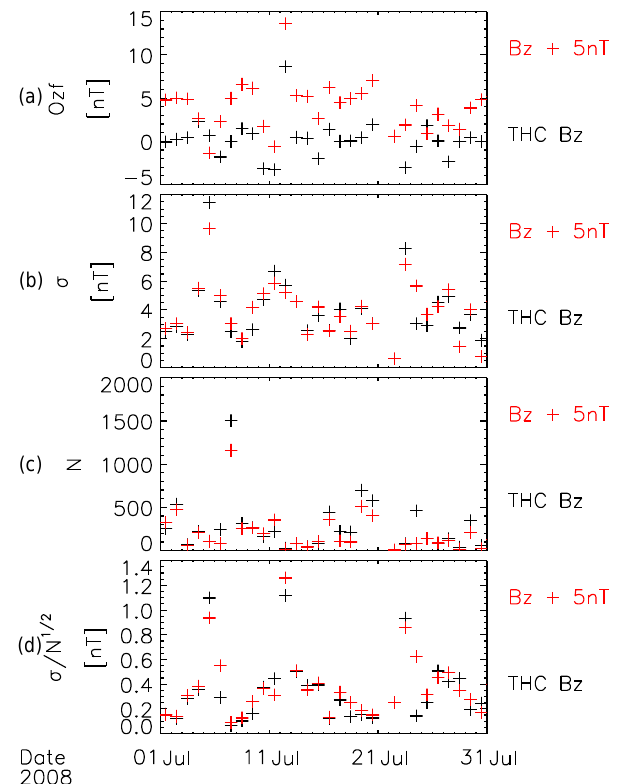
Figure 5. Daily spin axis offsets O z f (a) , standard deviation σ of contributing O z estimates (b) , number N of contributing O z esti- √ N (d) . Red crosses pertain to THC data with B z mates (c) , and σ/ component shifted by 5nT.